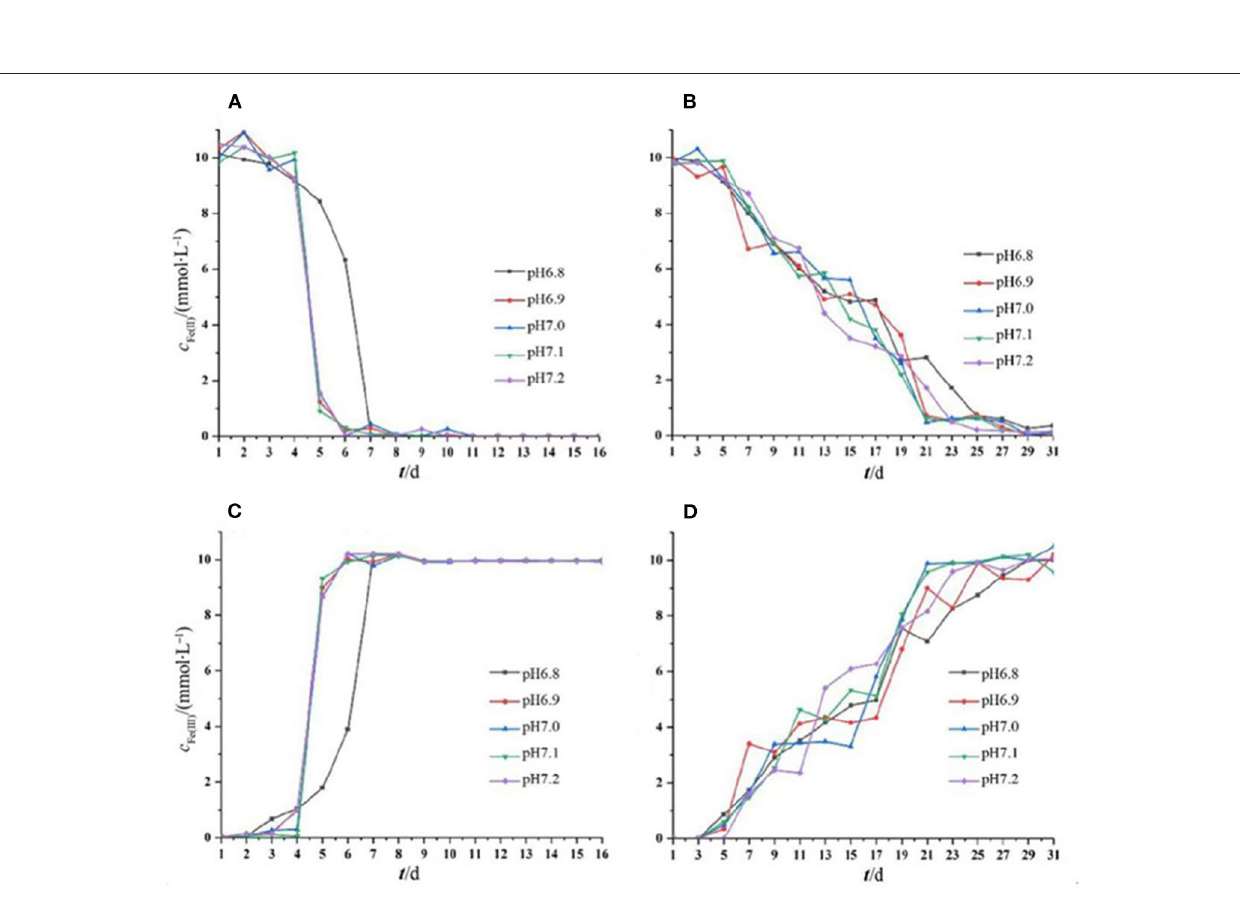
Frontiers in Microbiology |